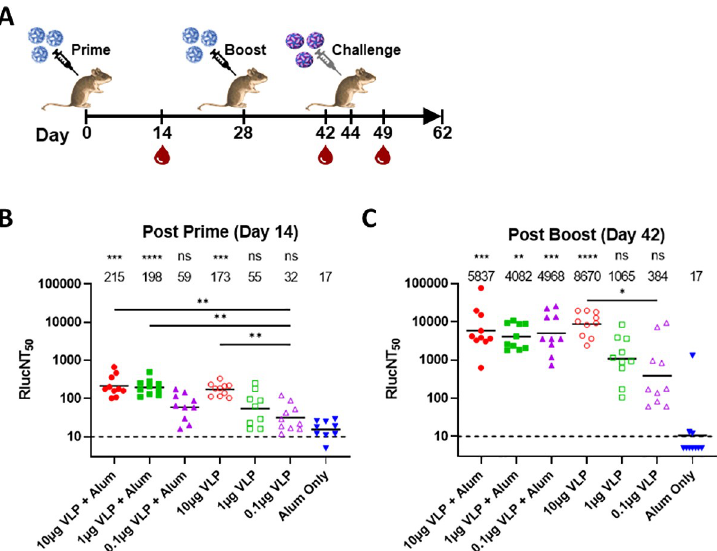
Fig 2. Zika VLP mouse study timeline and serum nAb responses. (2A) Schematic of experiment design. AG129 mice immunized either with Zika VLP or alum only (100 μ g) as control (n = 10). (2B) Serum RlucNT 50 titers post prime on Study Day 14 and (2C) post boost on Study Day 42 were determined. GMTs for each group are shown by lines and values are given above each group. NT 50 titers of individual mice are shown by symbols. The assay LOD was 10 (dashed lines) and titers below LOD are shown as 5. Kruskal-Wallis analysis followed by Dunn’s comparison tests on all pairwise comparisons within each time point were performed and statistical significance levels relative to each alum only group are denoted above the GMT value as: ���� P < 0.0001, ��� P < 0.001, �� P < 0.01, � P < 0.05, or ns (not significant). Additional significant differences between pairwise VLP groups are shown by bars and significance